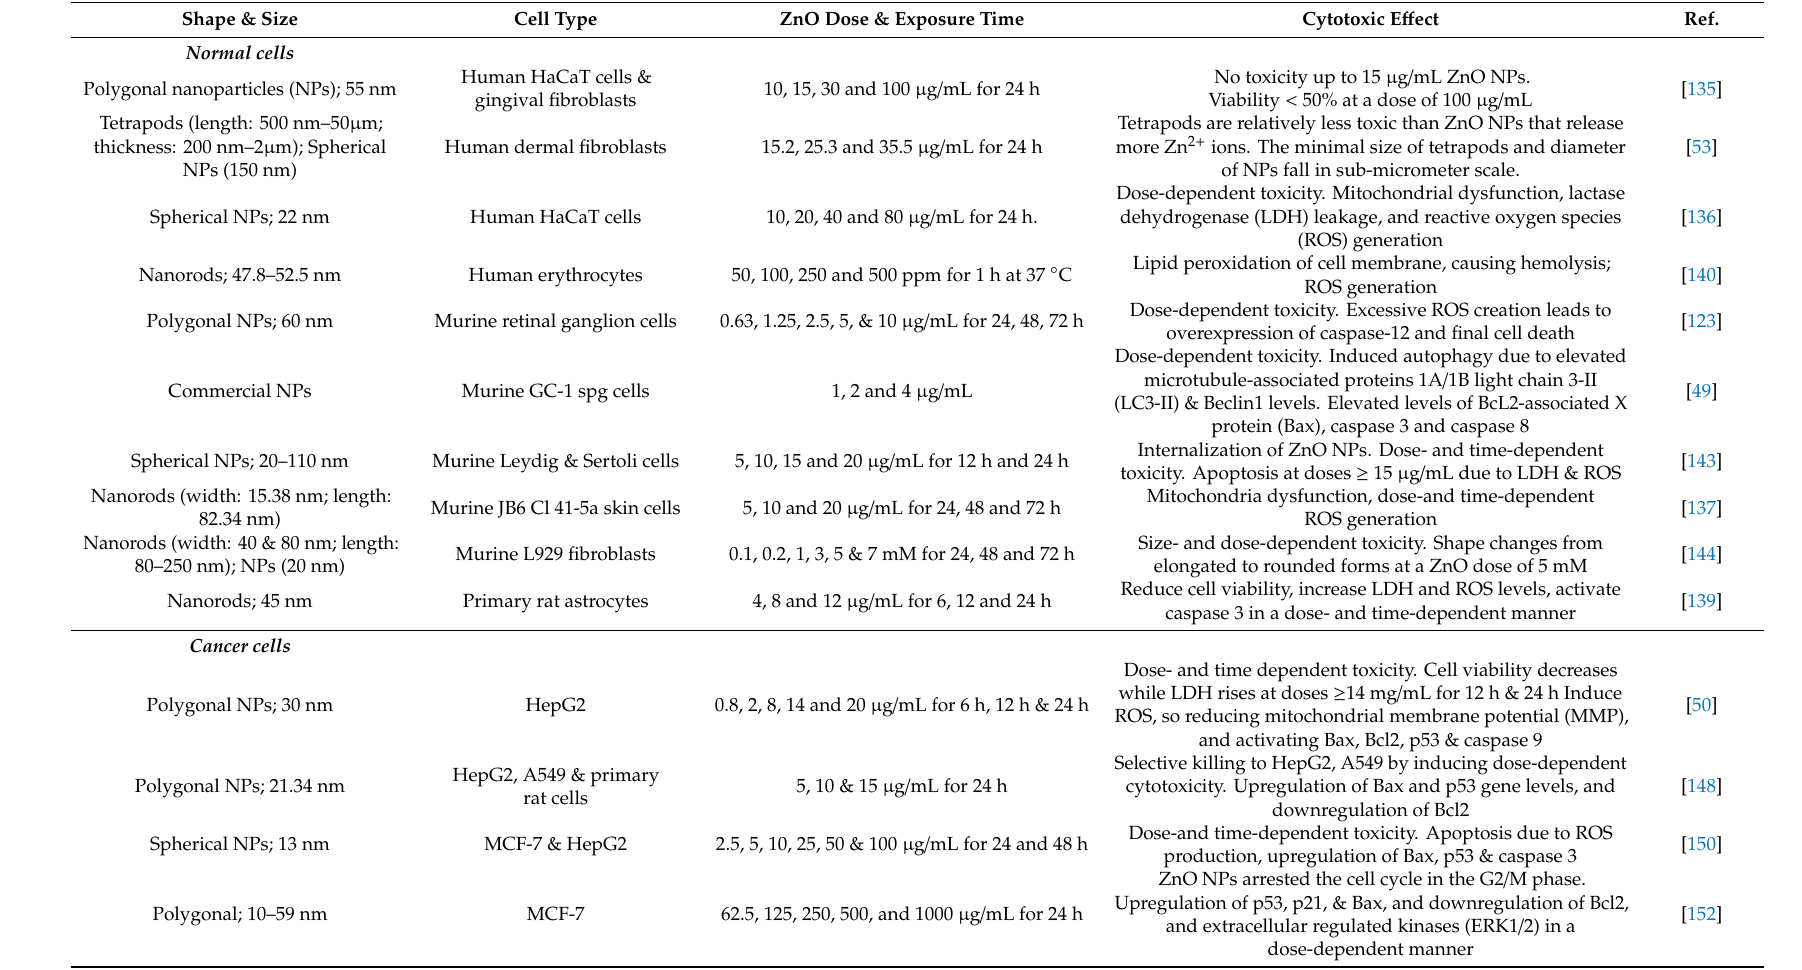
Table 1. Toxic e ff ects of ZnO nanostructures to normal mammalian cells and cancer